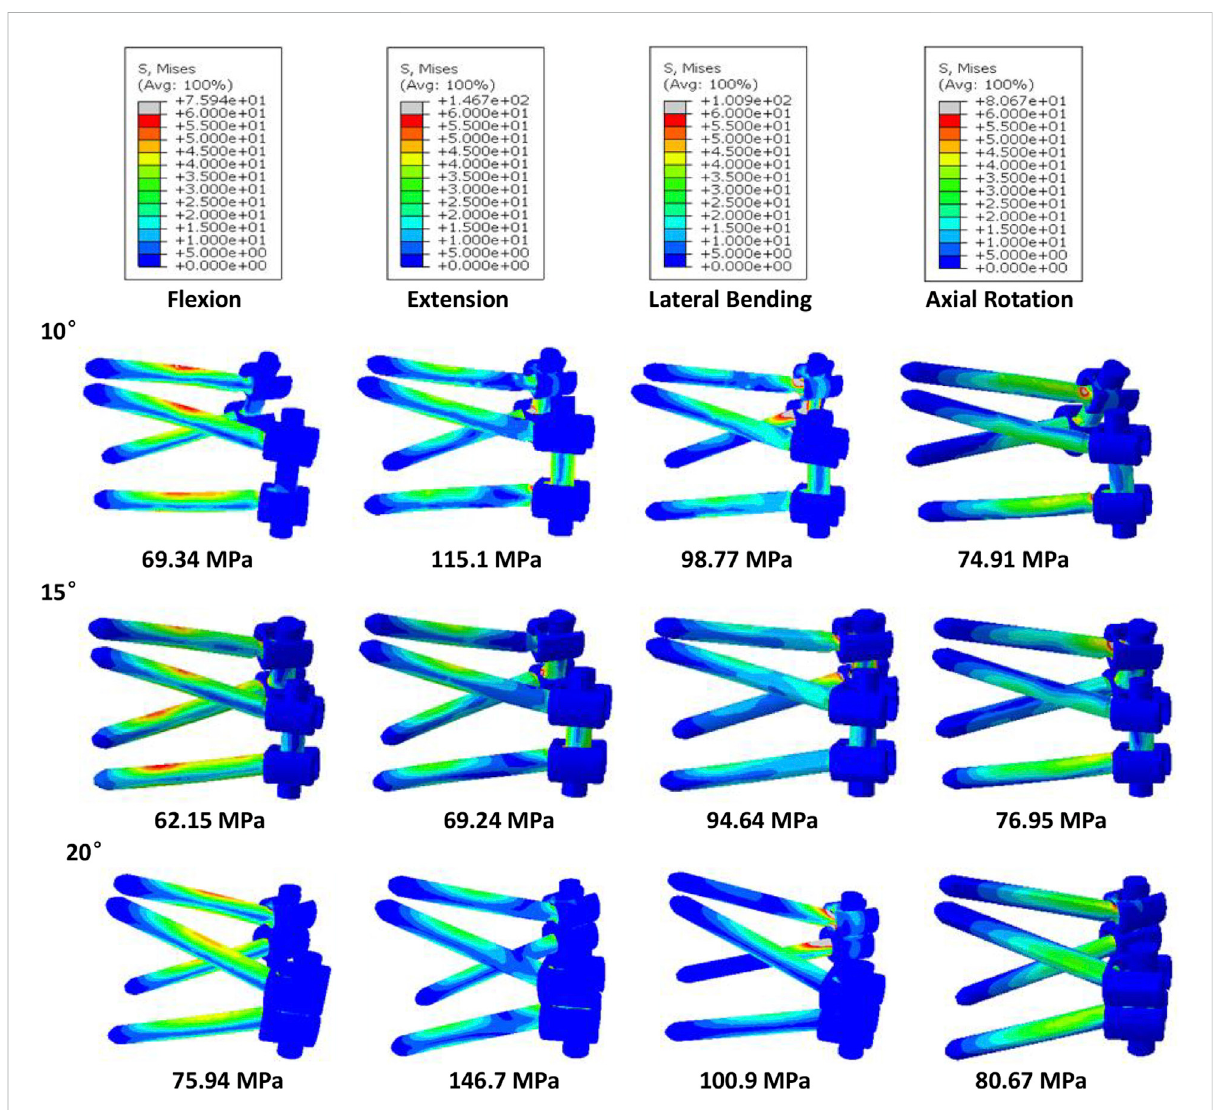
FIGURE 5 Von-Mises stress on the screws of the models for different screw inclination angles when placed under fl exion, extension, lateral bending, and axial rotation, with the peak stress noted beneath each